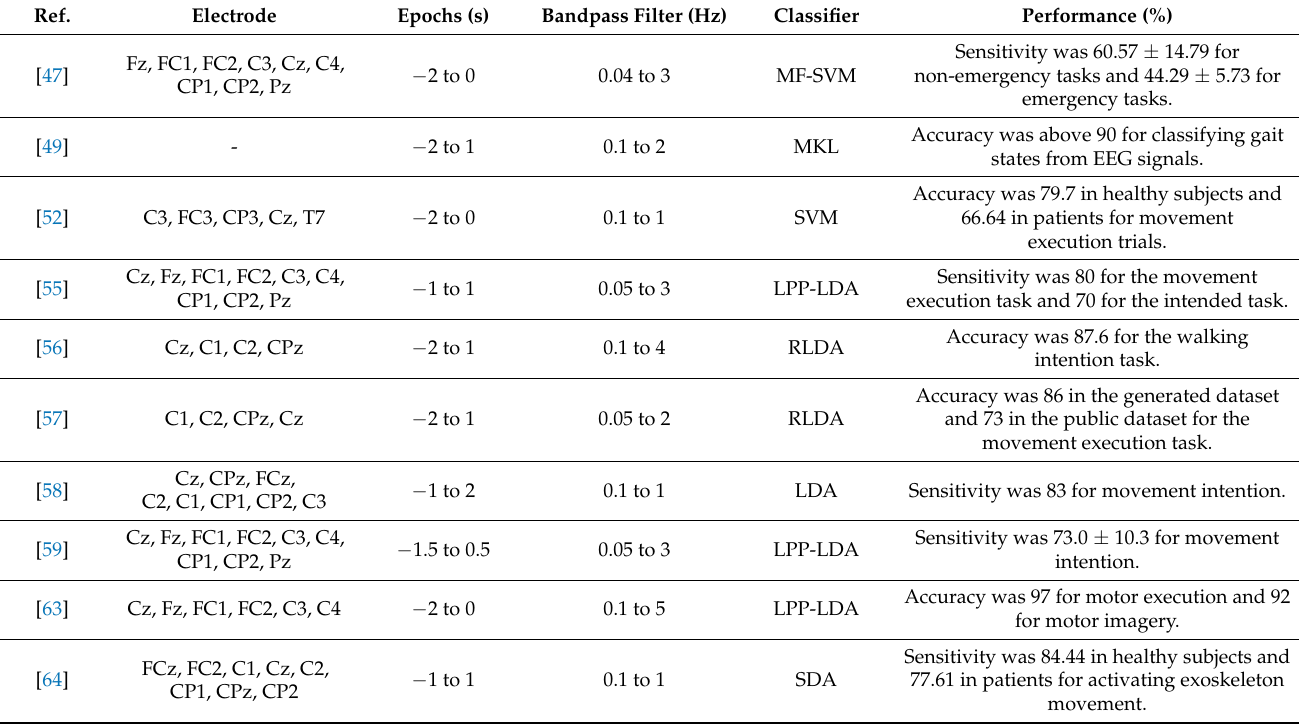
Table 3. Research studies, electrode, and classifiers used, and the outcomes of RT- and VR-MRCP- based BCI neurorehabilitation